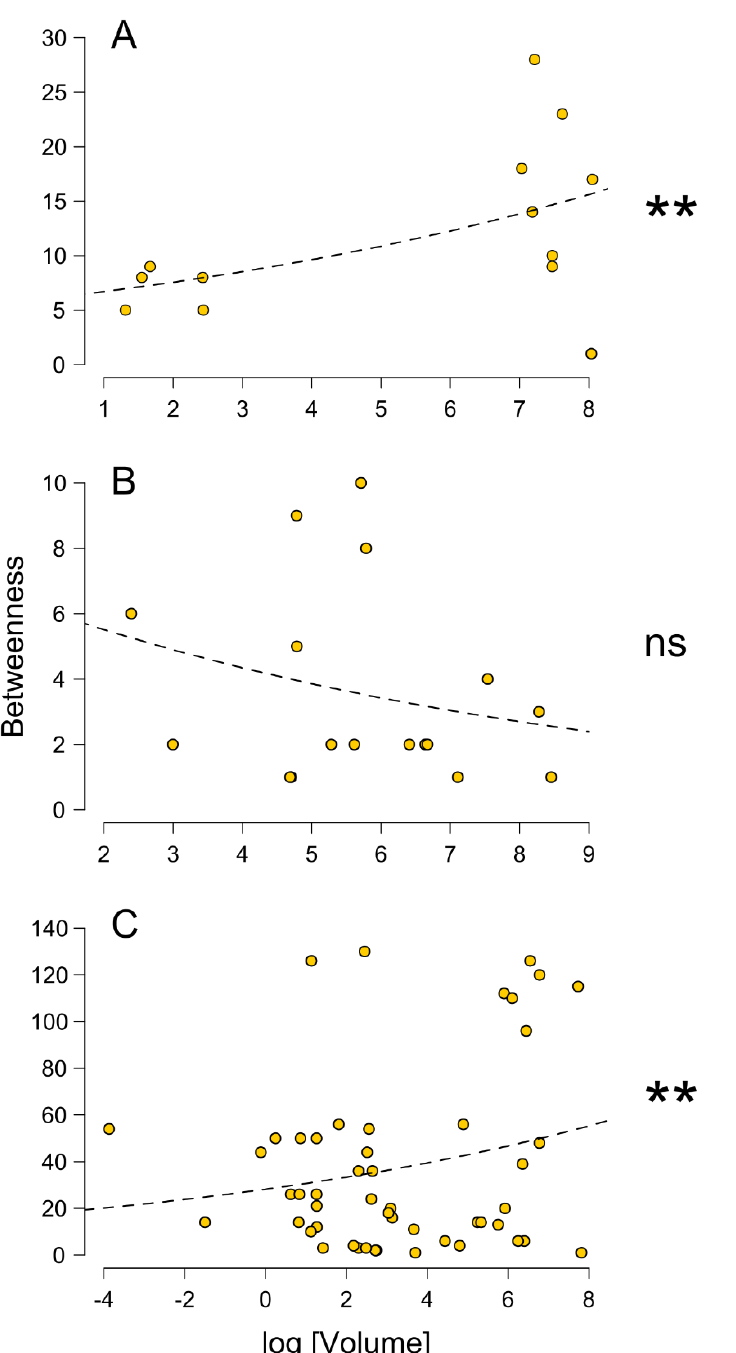
Figure 5. Relation between betweenness and volumes of nest mounds (transformed by logarithm) in the three sites, with models fitted (dashed lines). Each symbol is a nest having a betweenness >0. Asterisks represent the significance of the model (** p < 0.001). ns = Not significant. ( A ), Avorniolo Alto (AA), fir–dominated forest; ( B ), Le Cullacce (LC), mixed forest; ( C ), Fosso Fresciaio (FF), beech– dominated forest.